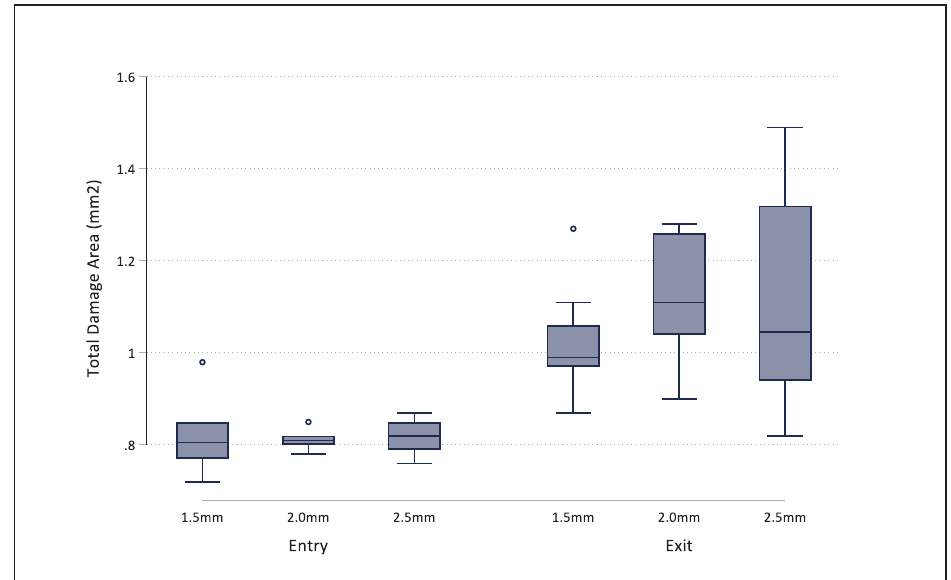
Figure 3. Boxplot graph of the total damage area by specimen thickness and surface (1, entry surface; 2, exit Figure 3.